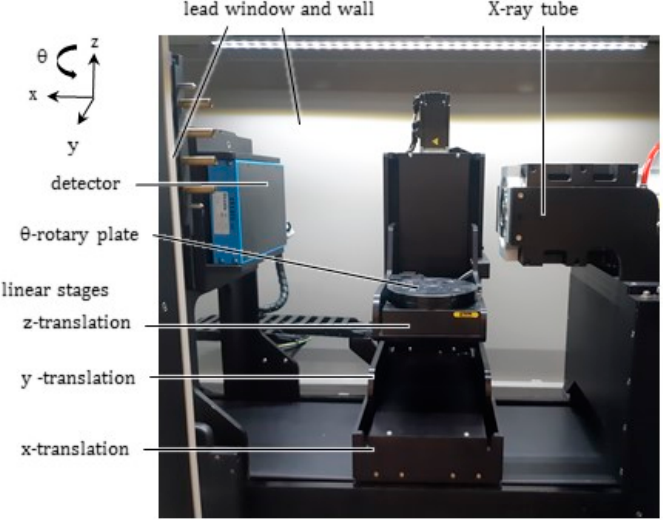
Figure 1. Inner view of the cabinet for X-ray microtomography available at Politecnico di Milano, showing the 4-dof motorized system for the sample positioning (see the reference frame), the tube and the movable detector.